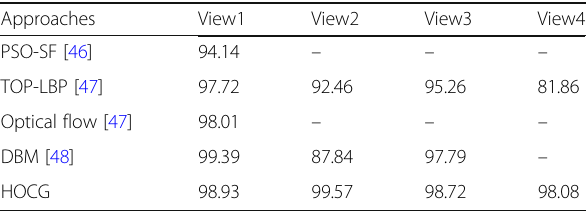
Table 5 Summary of the quantitative performance and a comparison with the state-of-the-art approaches from the PETS2009 dataset